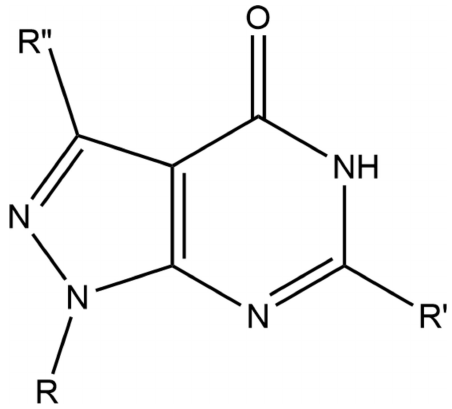
Figure 13 The molecular moiety used for the database search